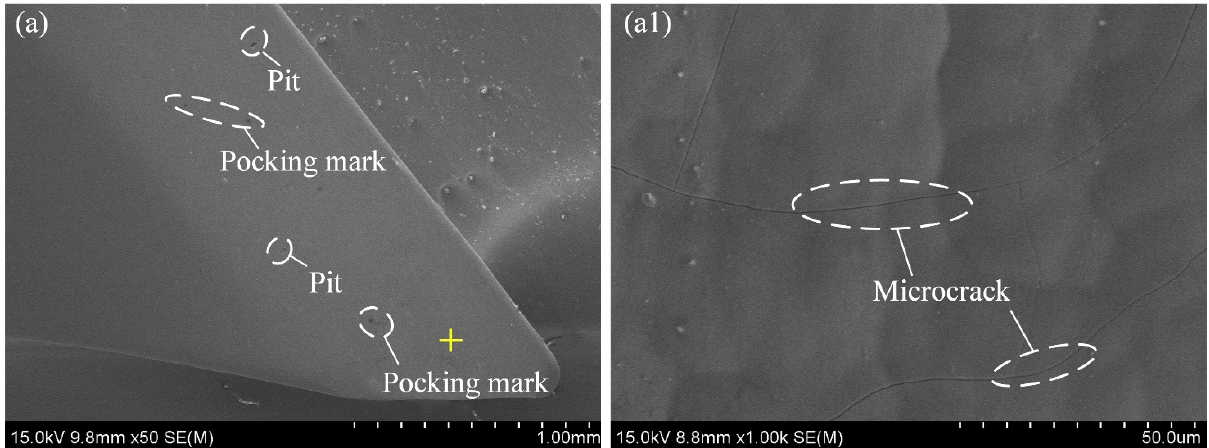
Figure 5. Surface morphology of new spindle hook teeth: ( a ) general micrograph of the hook teeth; and (a1) local micrograph of the hook teeth.